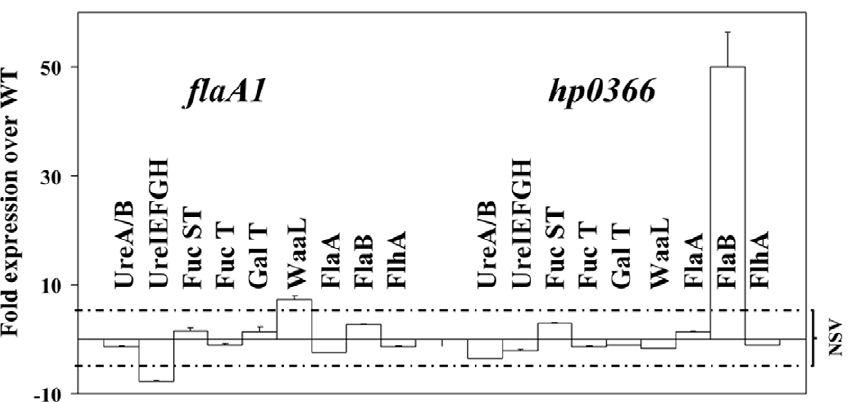
Figure 3. qRT-PCR analysis of the impact of the flaA1 or hp0366 inactivation on transcription of genes involved in urease, LPS and flagellum production. All data were normalized to the level of expression of the housekeeping gene hp1045 , the acetyl-CoA synthase. Differences are considered significant for . 5 fold difference compared with WT. The interval for non significant variation (NSV) is delimited by dotted lines. Error bars are for duplicate experiments done using the same sample of RNA. The same experiment was also repeated on RNA diluted 1/10 (v/v) and the same trend was observed (not shown). UreA/B: operon encoding both UreA and UreB. UreIEFGH: operon encoding 5 urease accessory proteins. FucST: fucose synthase. FucT: fucose transferase. GalT: galactose transferase. WaaL: O-antigen ligase. FlaA and FlaB: flagellins A and B. FlhA: flagella basal body and transcriptional regulator, also known as FlbA. doi:10.1371/journal.pone.0025722.g003 the H. pylori genome only encodes , 1600 ORFs, 2,300 protein spots were detected by Cy5 labeling. This suggests that numerous modifications. Out of these, 756 spots were detected using the the ProQ-emerald and Cy5 signals was calculated for a subset of 100